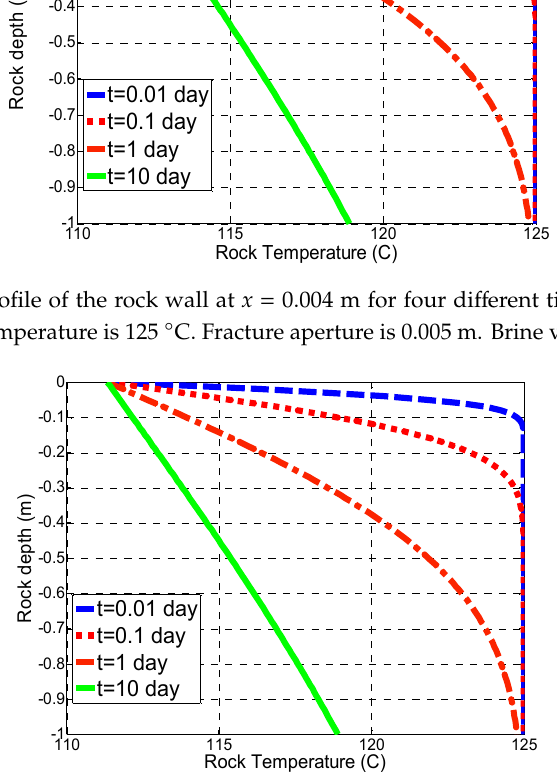
Figure 12. Cooling profile of the rock wall at x = 0.04 m for four different times: 0.01, 0.1, 1, and 10 days. Initial rock temperature is 125 °C. Fracture aperture is 0.005 m. Brine velocity is 0.001 m/s.